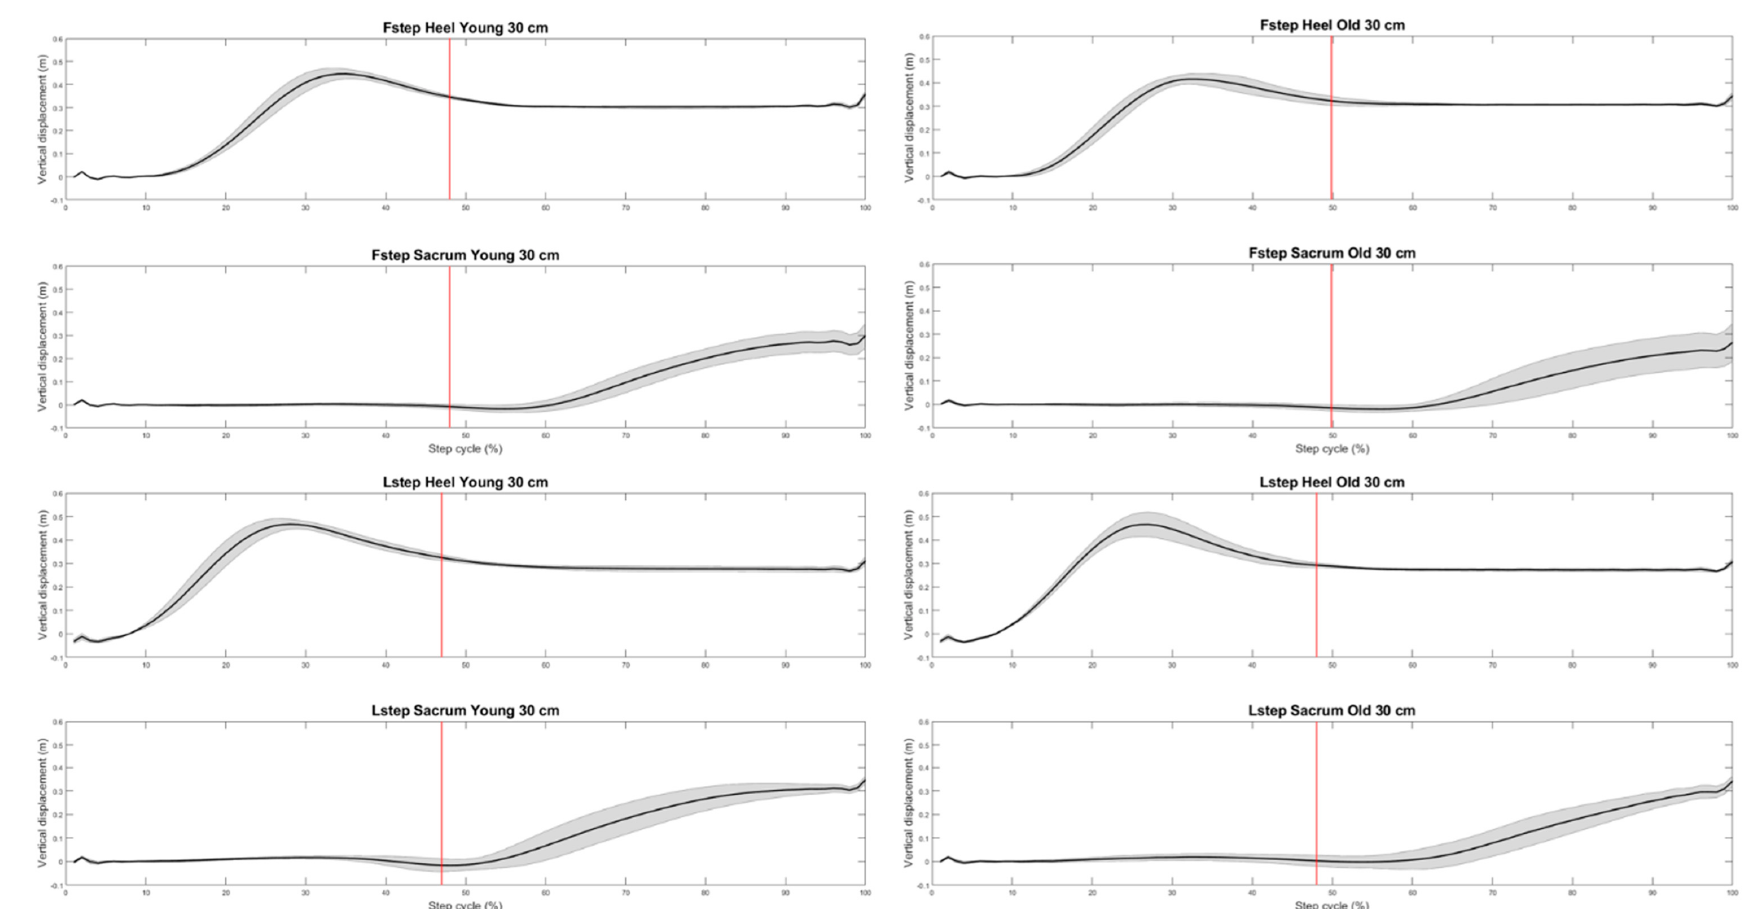
Figure 1. Averaged vertical displacement of the heel and sacrum in young (left column) and older women (right column) at 30 cm step height in forward direction (Fstep) and lateral direction (Lstep). Vertical lines indicate average point of transition from foot clearance to pull-up